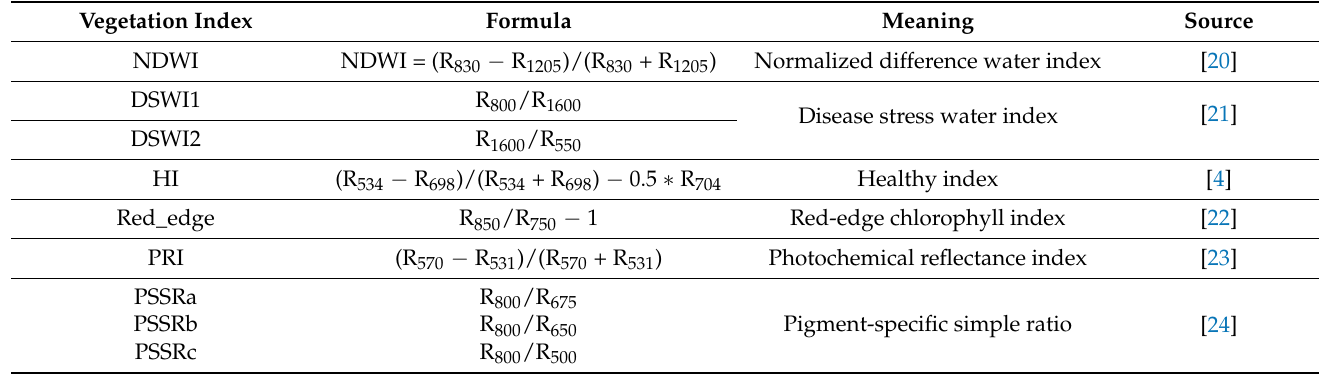
Table 2. Definitions of typical spectral vegetation indices (VIs) used in this study. The number in the subscript stands for wavelengths and the unit is